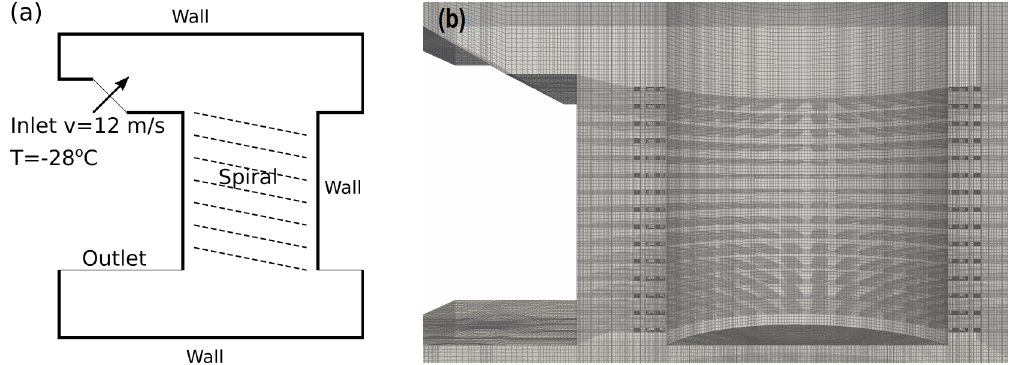
Figure 3. ( a ) Schematic of the computational domain for the full industrial spiral, and ( b ) structured mesh of the interior of the domain. The spiral comprises 15 complete revolutions, whilst 360 pasties are arranged on each tier (full revolution). The overall height of the spiral is 6